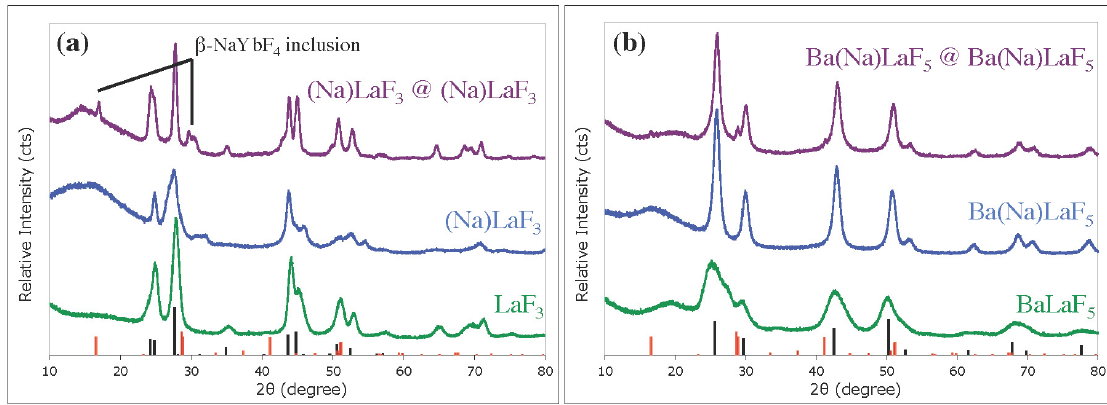
Table 1. Inductively coupled plasma optical emission spectroscopy (ICP-OES) compositional analysis of 0.5%Tm, 20%Yb codoped (Na)LaF